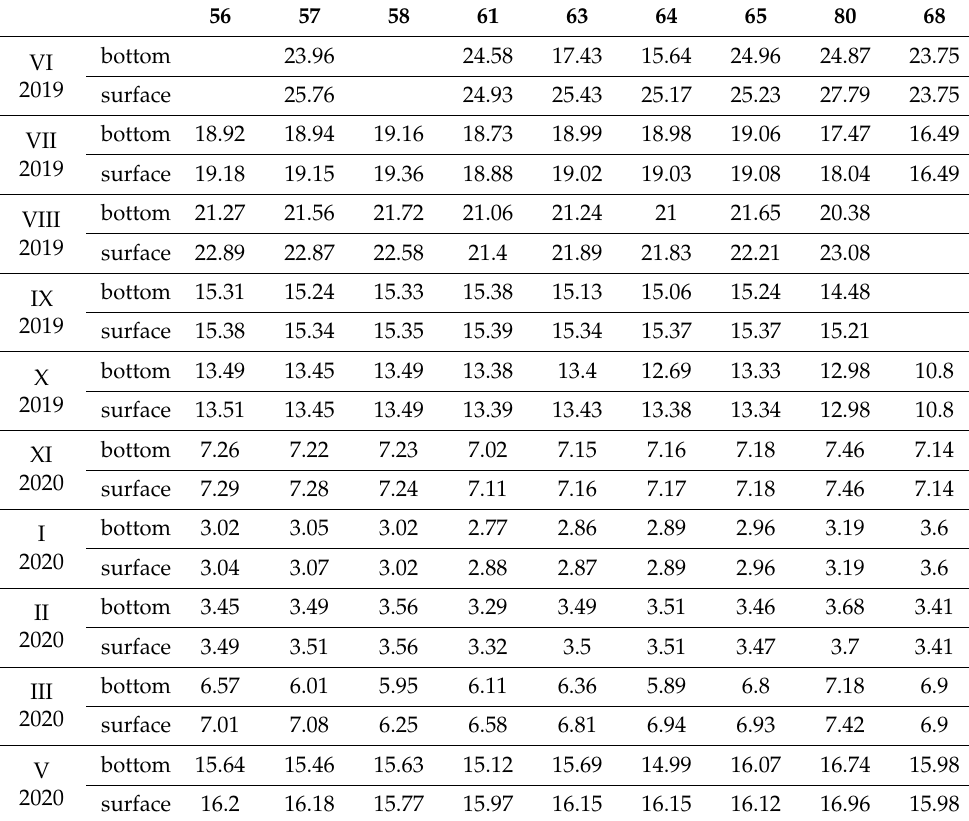
Table 4. Water temperature [ ◦ C] in Swarz˛edzkie Lake and Cybina at the surface and at the bottom at all measuring